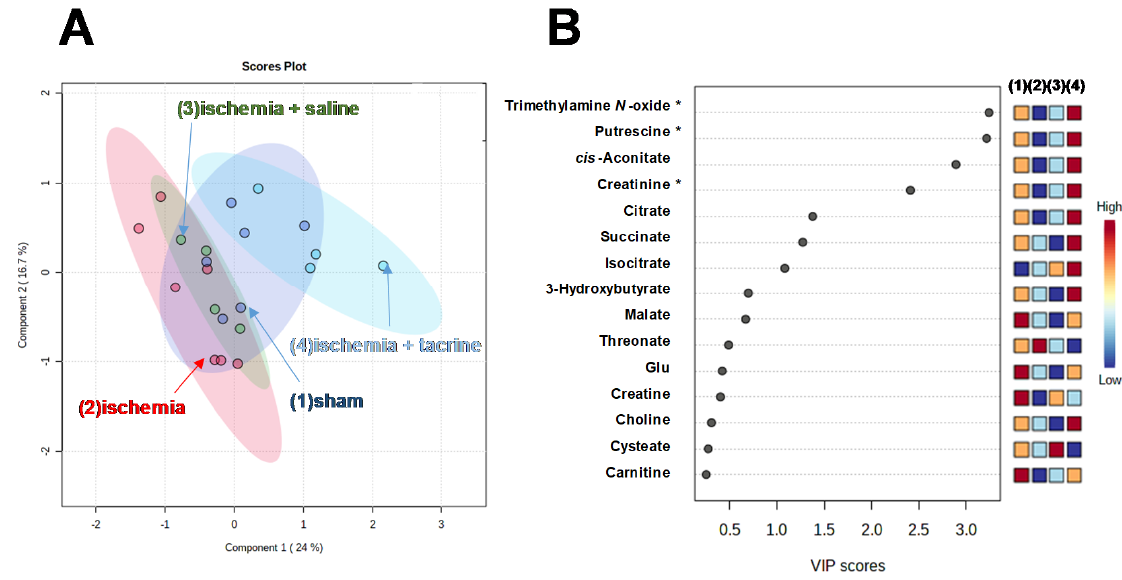
Figure 3. PLS-DA of salivary metabolite concentrations. ( A ) Score plots. ( B ) VIP scores. The metabolite detected in detection limits in more than 50% of the samples were selected and, of these, the metabolites showing variance value within the top 50% were analyzed. A total of 42 metabolites were used. The developed model yielded R 2 = 0.72 and Q 2 = 0.40 using two principal components. ANOVA tests were conducted for each metabolite, and p -values were adjusted by FDA. The metabolites showing q -value < 0.05 are shown with * in the VIP score. The right four column panels indicate the heatmap of four groups. The labels (1)–(4) on the heatmap correspond to the groups shown in ( A ), e.g., (1) sham group.